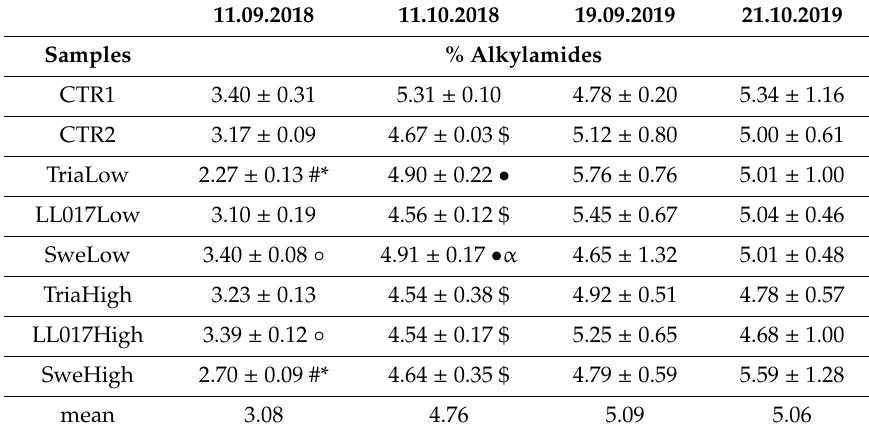
Table 4. Alkylamide contents from di ff erent harvests (11.09.2018, 11.10.2018 first year, 19.09.2019, 21.10.2019 second year) for each treatment. Values expressed are means ± S.D. of three parallel measurements for plant material samples. # p ≤ 0.05 vs. CTR1 (11.09.2018) * p ≤ 0.05 vs.